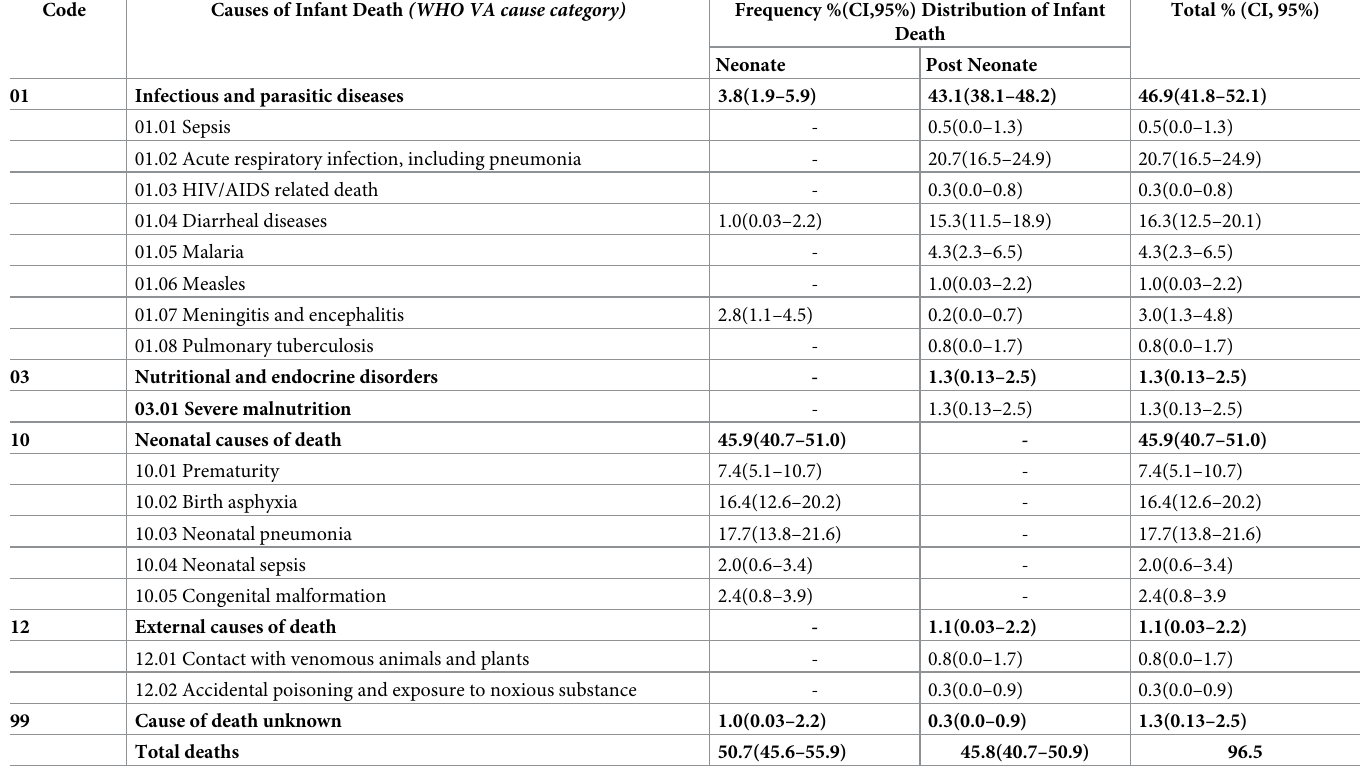
Table 2. Cause-specific infant mortality fraction by WHO VA category and age group in Eastern Ethiopia,